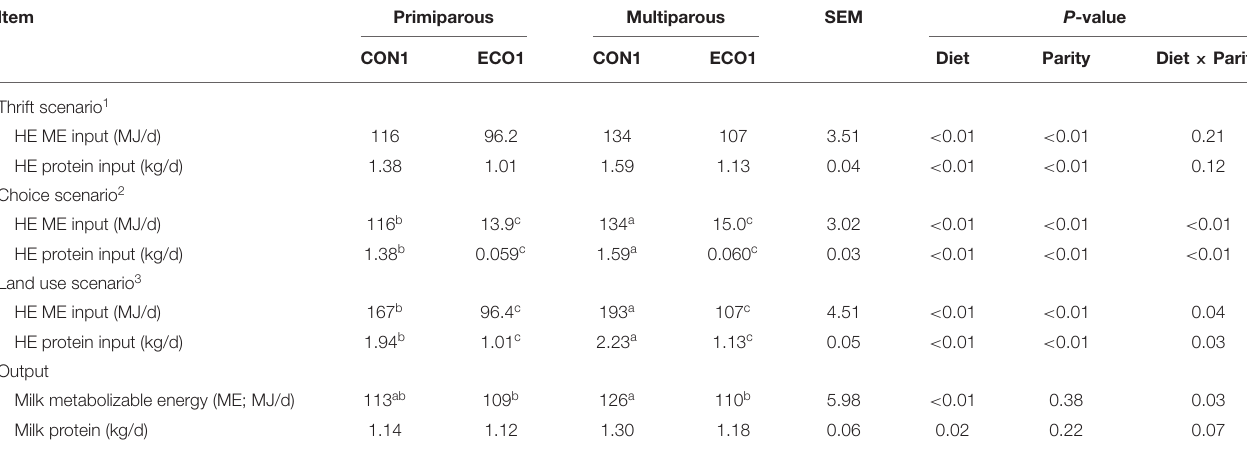
TABLE 7 | Human-edible (HE) nutrient inputs and outputs of mid-lactation cows fed a conventional lactation diet or a by-product-based diet (Experiment 1). Item Primiparous Multiparous SEM P -value CON1 ECO1 CON1 ECO1 Diet Parity Diet ×